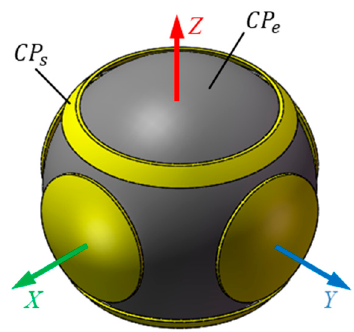
Figure 6. Simulation model of the proposed capacitive sensor.